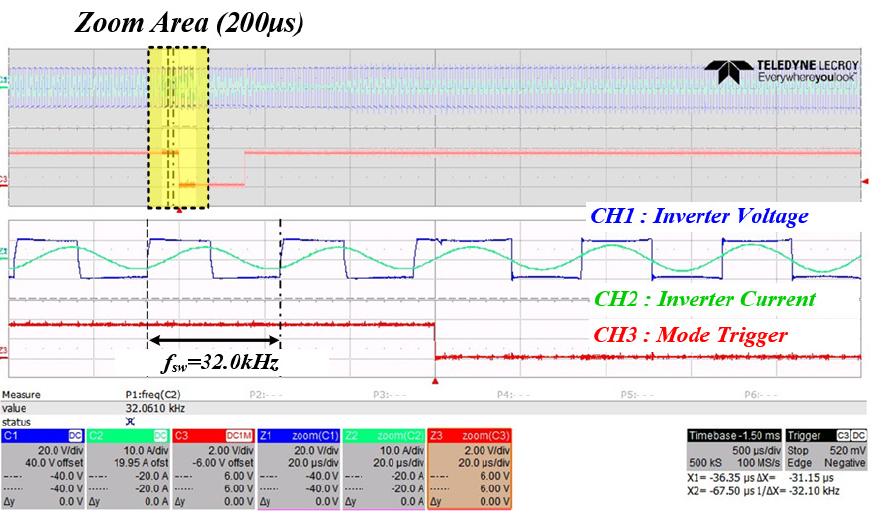
Figure 22. Inverter output waveform when mode 1 changes to mode 2 (CH1: inverter voltage (blue), CH2: inverter current (green), CH3: mode trigger